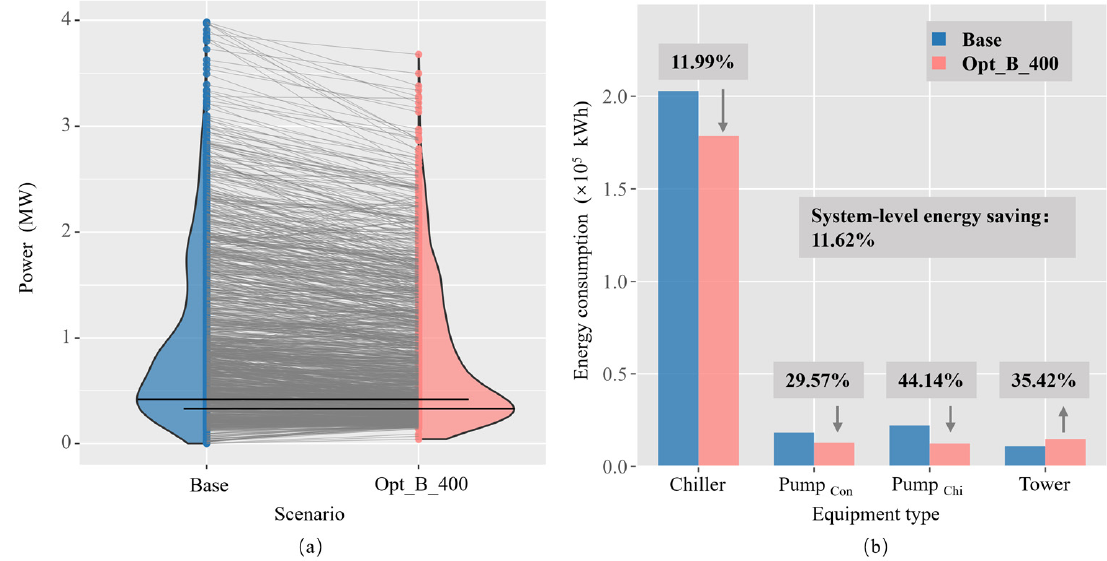
Figure 10. ( a ) Results of power comparison; ( b ) Comparison of cumulative electricity consumption by equipment type. (In the figure, red represents the use of Opt_B_400 scheme, blue represents the use of Base scheme).